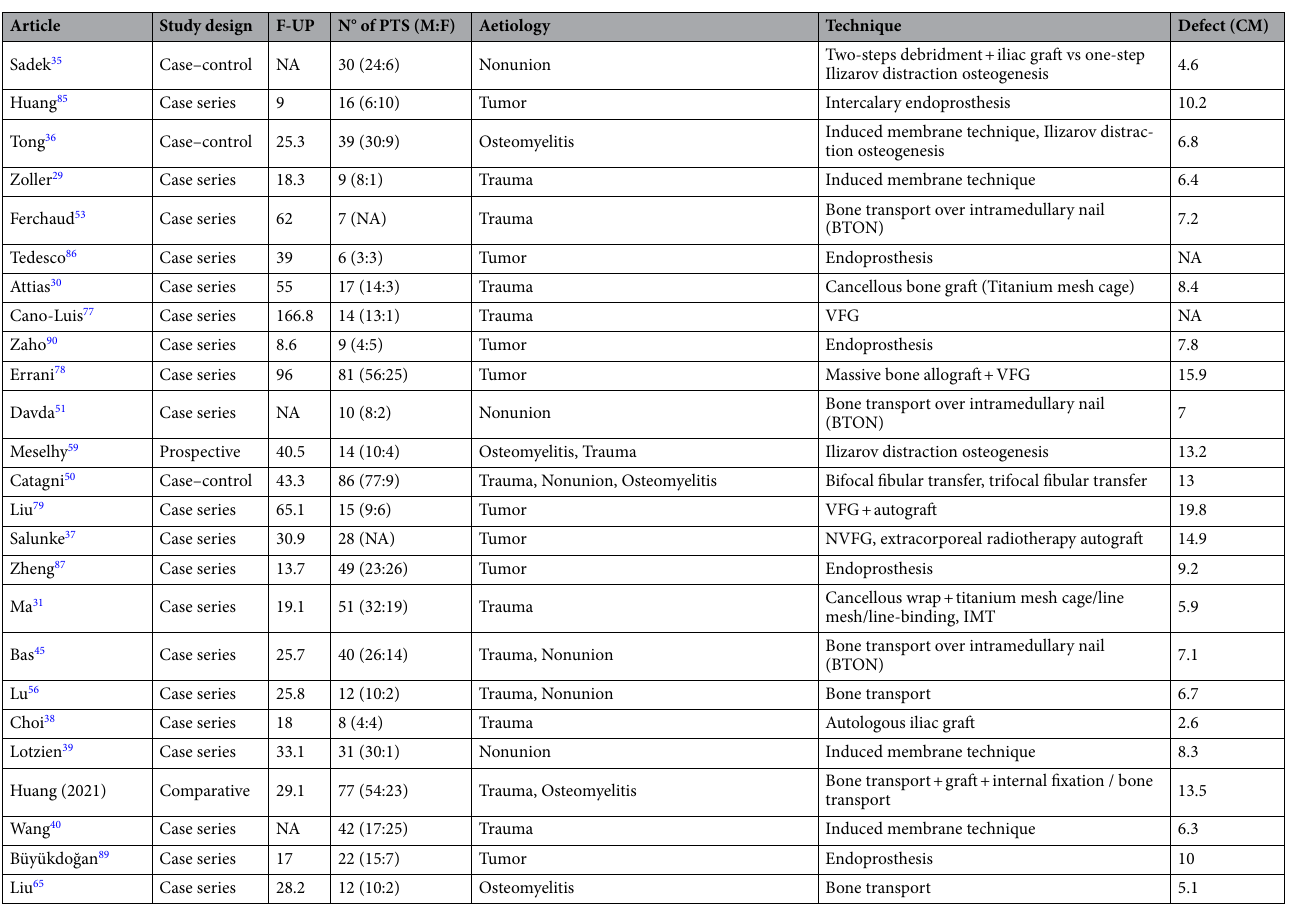
Table 1. Summary of all the studies characteristics. VFG (vascularised fibular graft), NVFG (non-vascularised fibular graft), BTON (Bone Transport Over Intramedullary Nail), PMMA (Poly Methyl Methacrylate), IMT (Induced Membrane Technique).